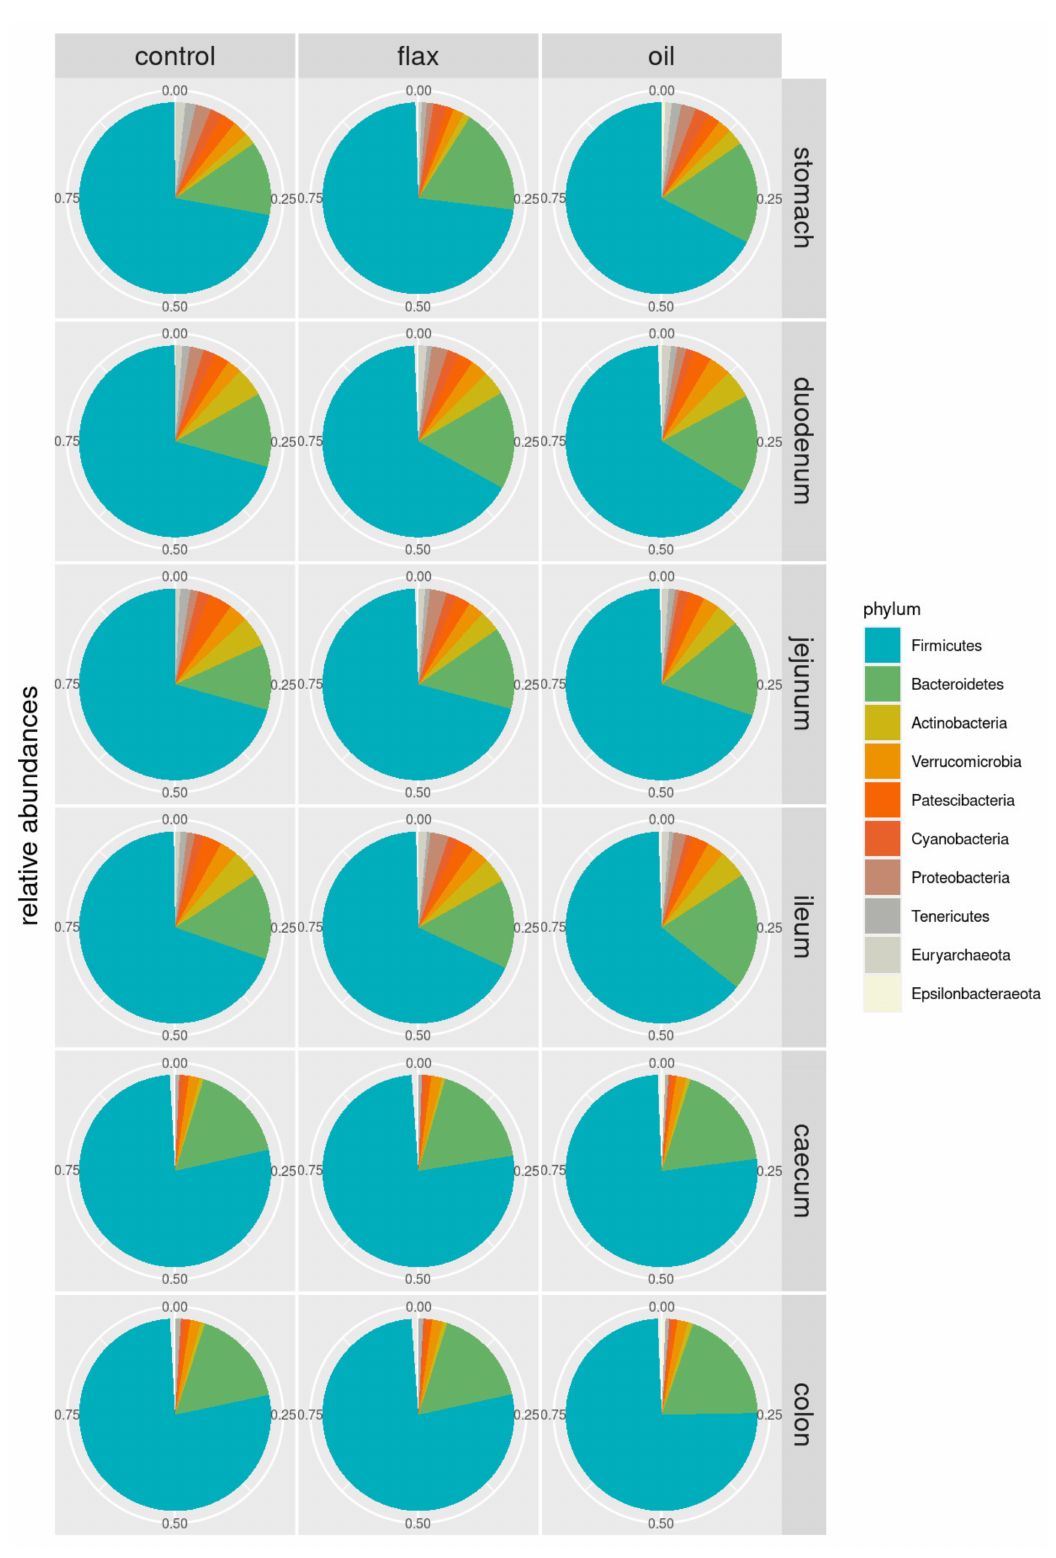
Figure 1. Pie chart of phylum relative abundances along the gastrointestinal tract in control ( n = 5), flax (supplemented with flaxseed, n = 5) and oil (supplemented with fish oil, n = 5)